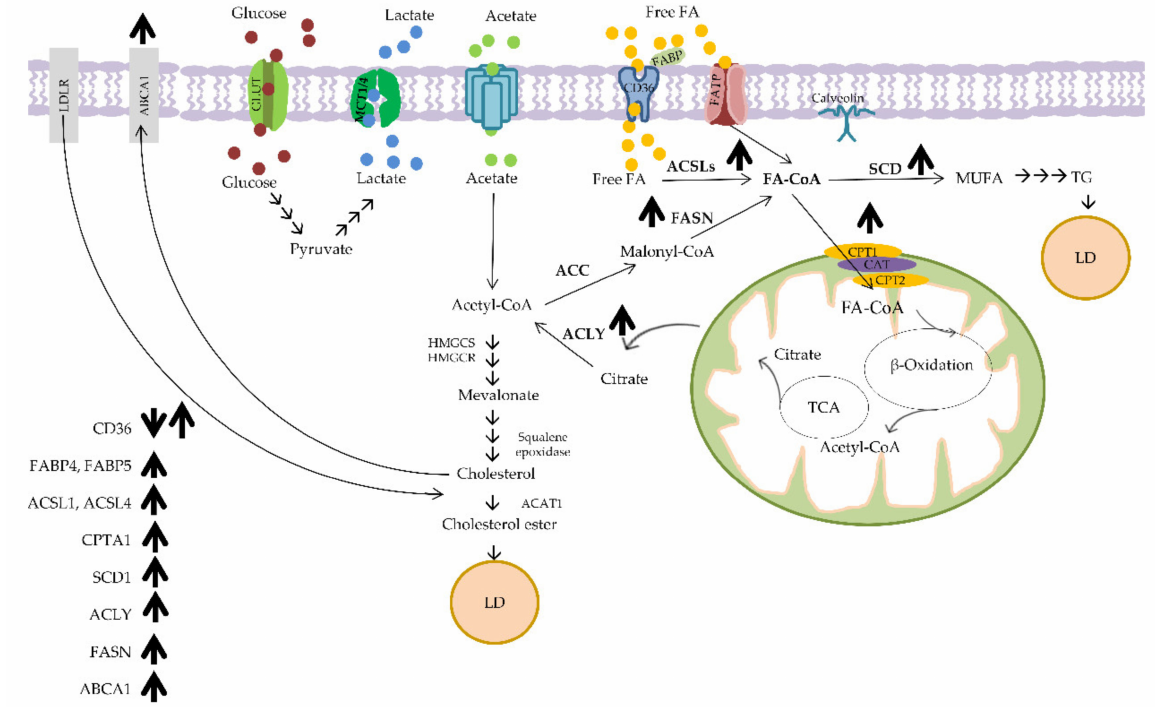
Figure 3. Altered lipid metabolism in CRC. Dysregulated enzymes contributing to abnormal lipogenesis and FAO are clearly represented, with ↑ indicating upregulation, ↓ downregulation and ↓↑ downregulation at an early stage of carcinogenesis and upregulation later in metastatic cancer. TG: